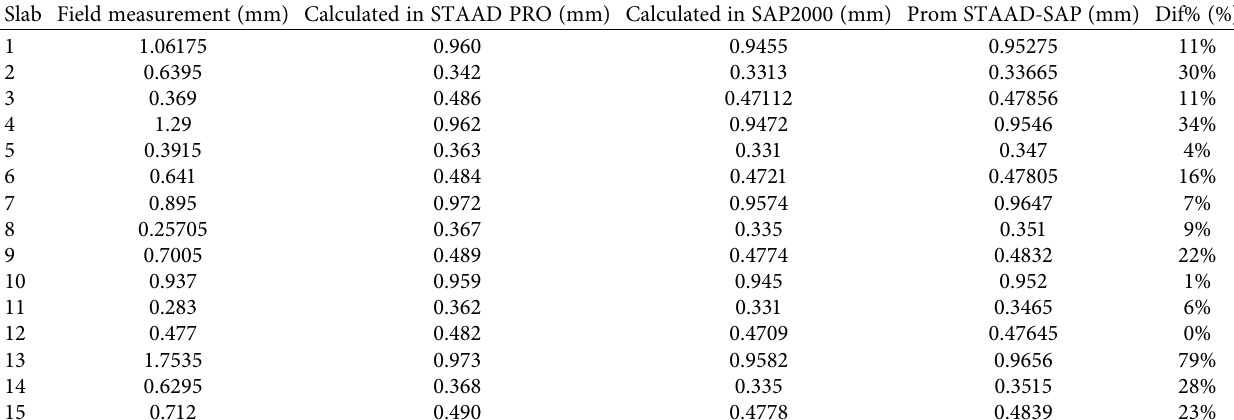
Table 10: Maximum deformations in slabs.